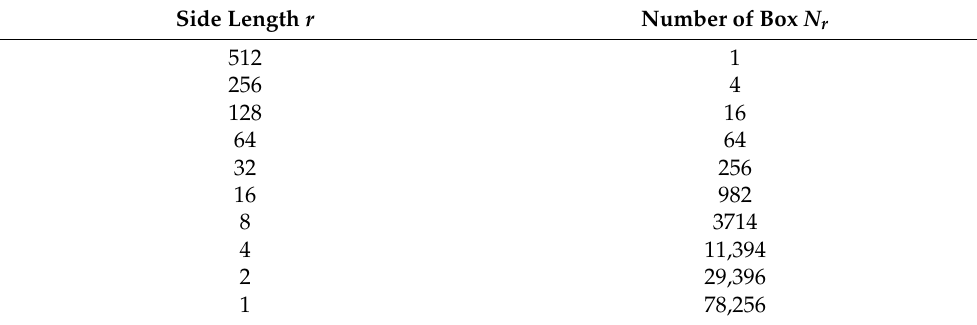
Table 2. Number of boxes covered with holes for different edge lengths of boxes.